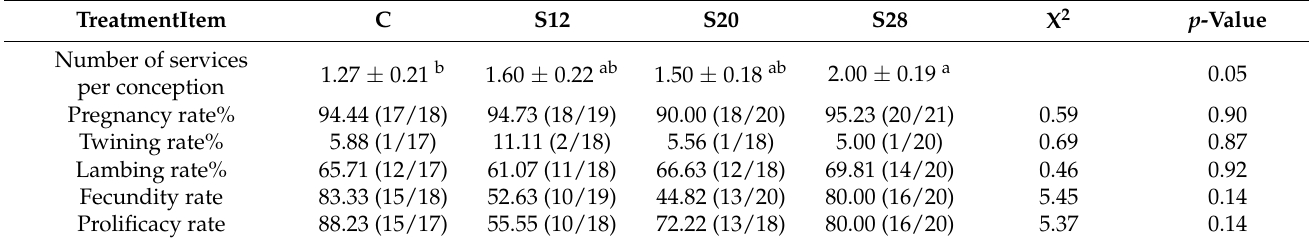
Table 5. The effects of different levels of sunflower hulls in total mixed ration on reproductive parameters of Awassi ewes.